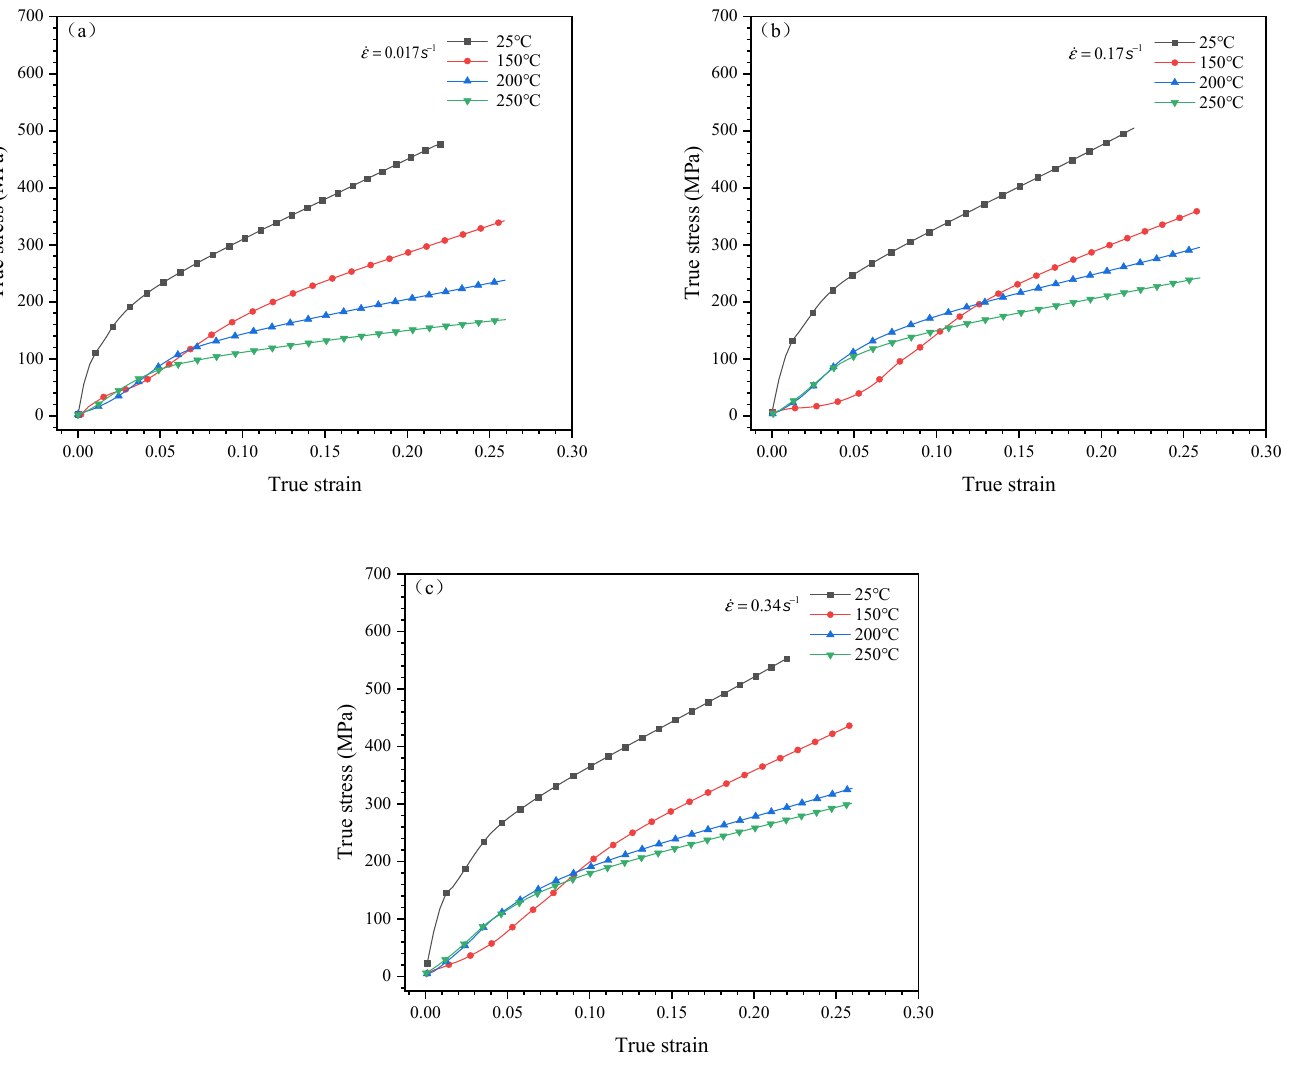
Figure 6. The true stress and true strain of AZ31B at different experiment temperatures under each . . . ε = 0.017 s − 1 ; ( b ) ε = 0.17 s − 1 ; ( c ) ε = 0.34 s − 1 strain rate. ( a )